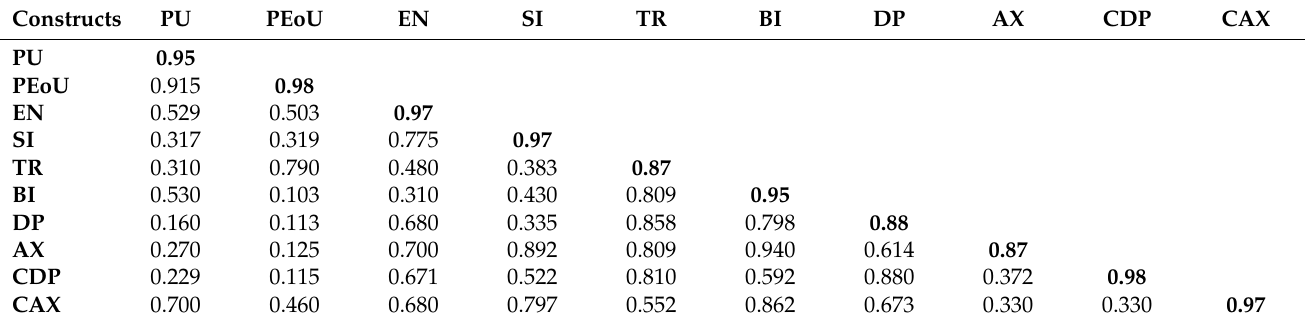
Table 5. Correlations of